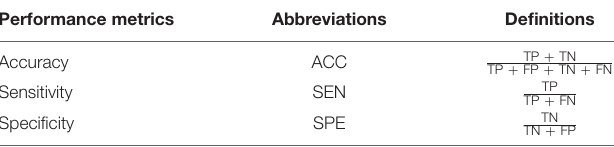
TABLE 2 | Different performance metrics.